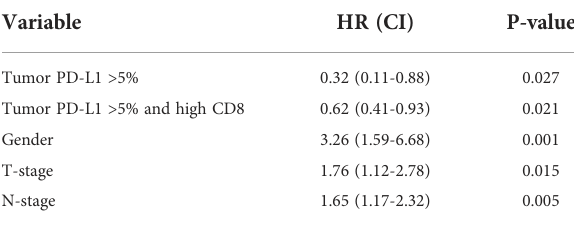
TABLE 3 Univariate analysis for overall survival.